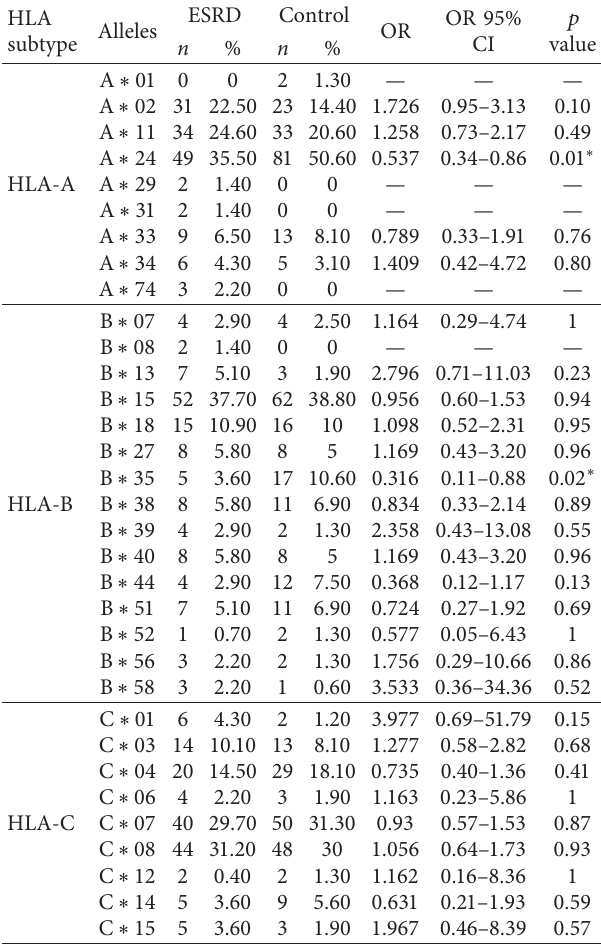
Table 2 indicates the class II HLA types with fre- quency > 1% in the ESRD or control groups. The high- frequency alleles of HLA class II were HLA-DRB1 ∗ 12 (44.20% in ESRD, 50% in control group, and 47.30% in both groups), HLA-DQB1 ∗ 03 (49.30% in ESRD, 51.90% in control group, and 50.6% in both groups), and HLA- DPB1 ∗ 13 (22.50% in ESRD, 22.50% in control group,